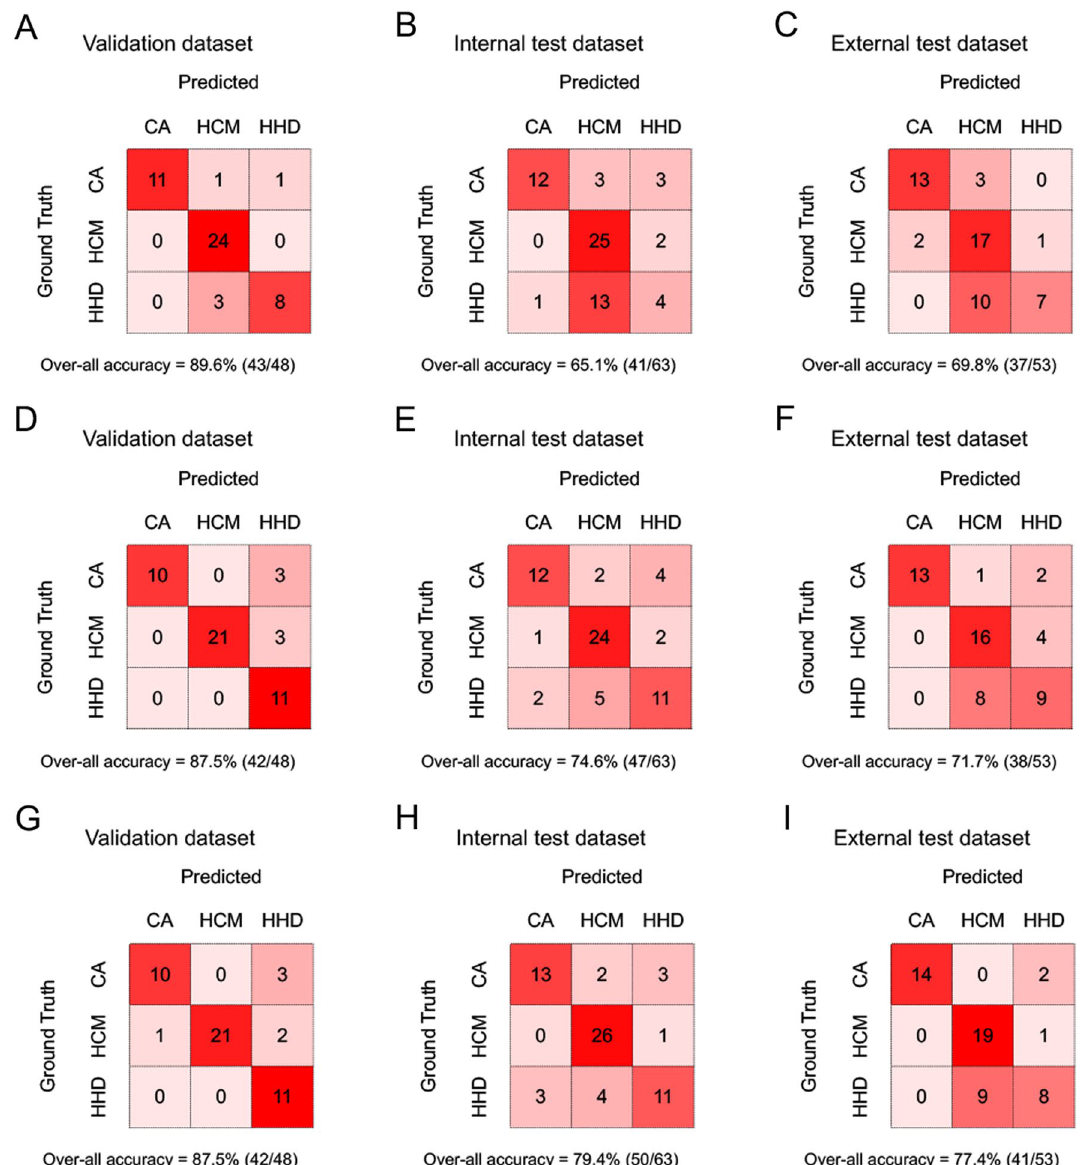
Fig. 4 Confusion matrix comparison across Model 1 ( A – C ), Model 2 ( D–F ) and Model 3 ( G–I ) in the validation, internal test and external test datasets, respectively. Note that all models noticeably confuse HCM and HHD in the external test dataset. HCM, hypertrophic cardiomyopathy, CA, cardiac amyloidosis, HHD, hypertensive heart